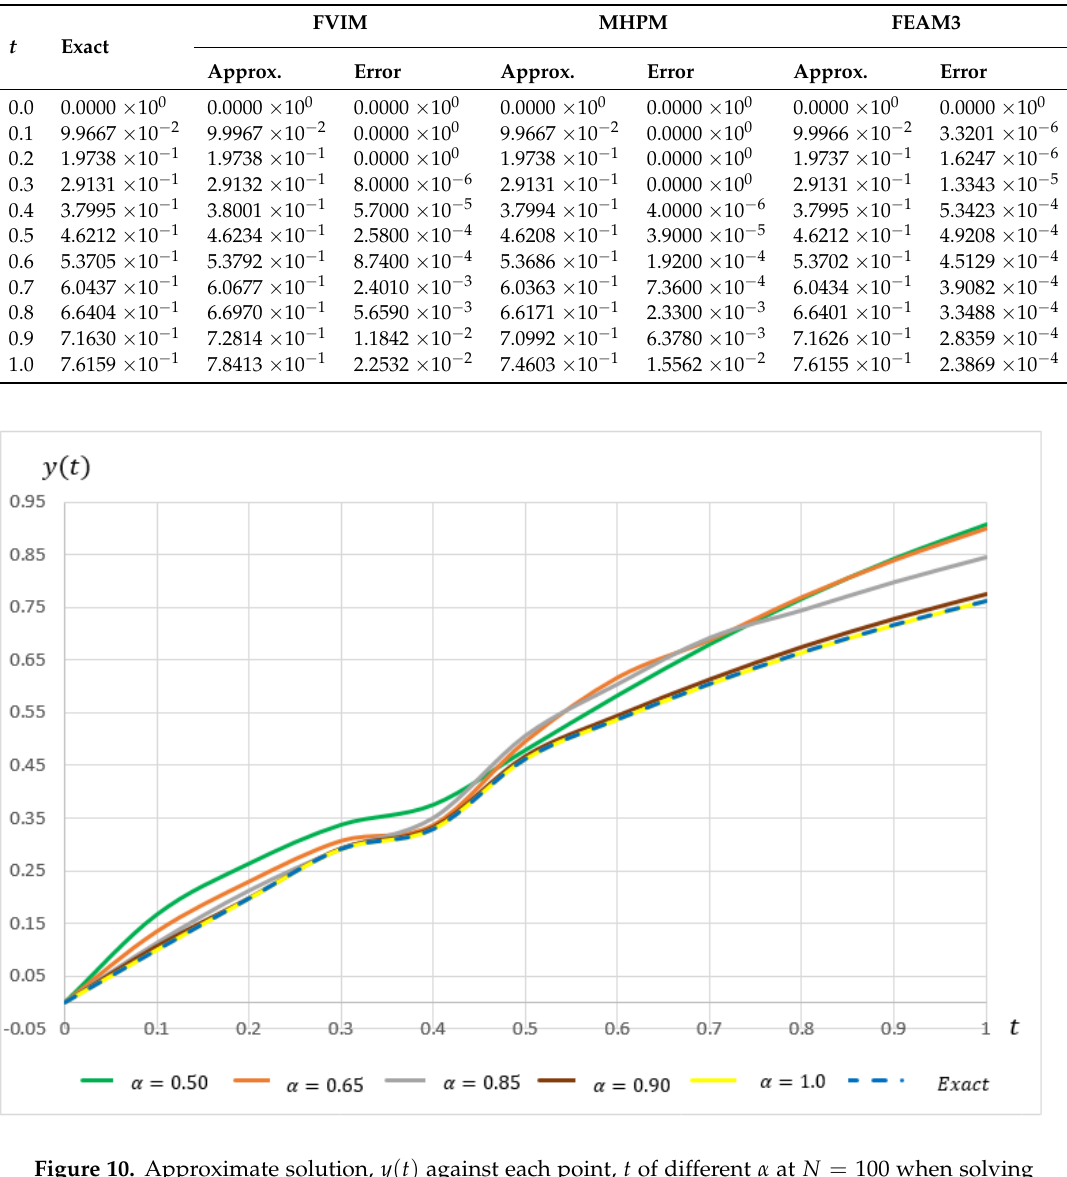
Figure 10. Approximate solution, y ( t ) against each point, t of different α at N = 100 when solving Example 6 using